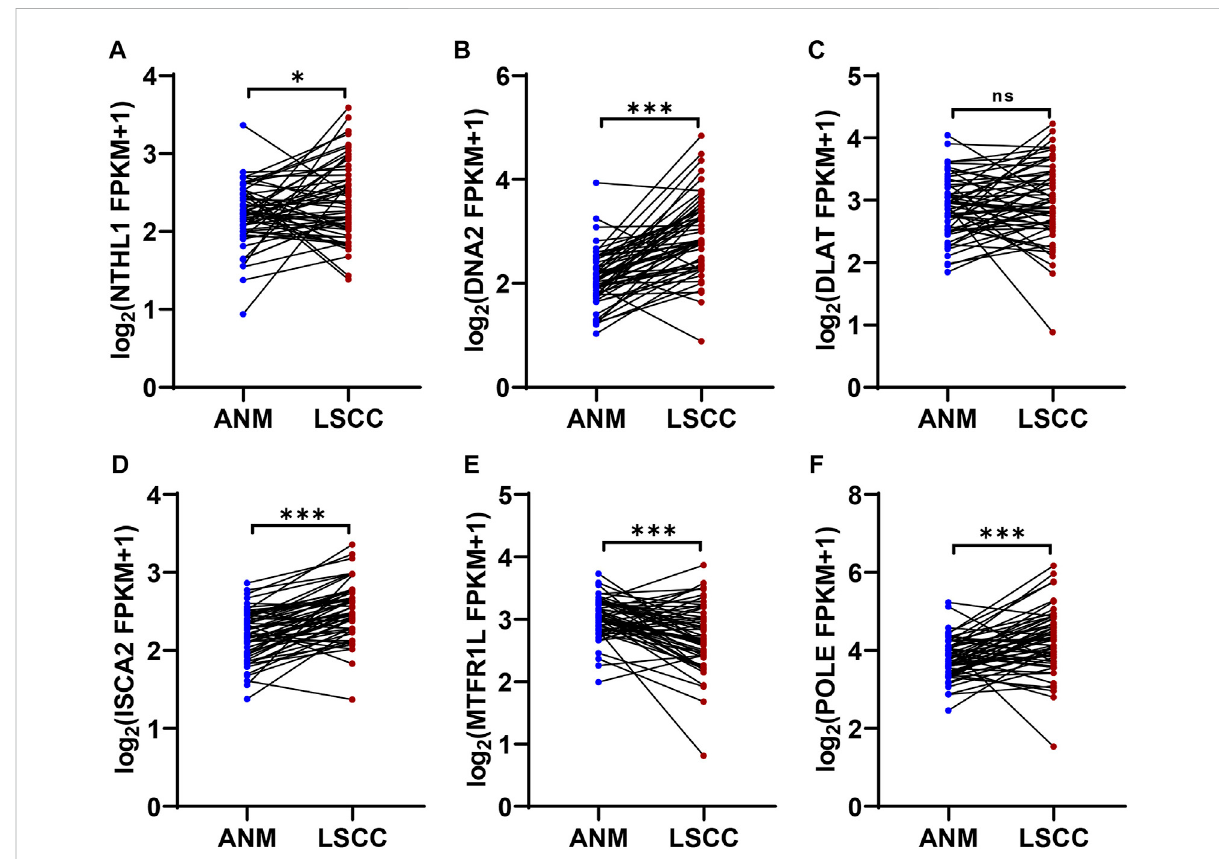
FIGURE 8 Expression validation of genes in 12-CRGs signature using RNA-Seq data of LSCC and ANM tissues (A – F) Expression levels of NTHL1 (A) , DNA2 (B) , DLAT (C) , ISCA2 (D) , MTFR1L (E) and POLE (F)